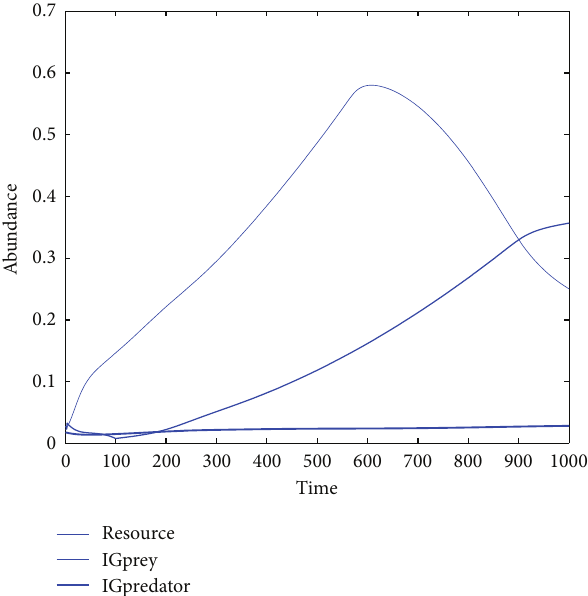
Figure 3: The population dynamics of the IGP system with diffusion. All parameter values are the same as Figure